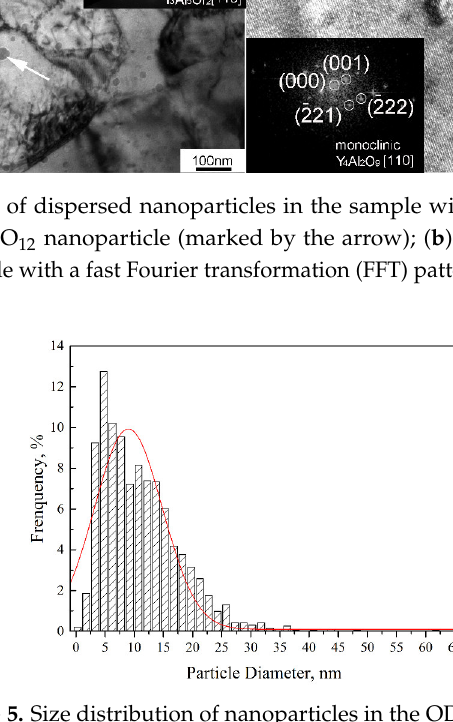
Figure 5. Size distribution of nanoparticles in the ODS sample.